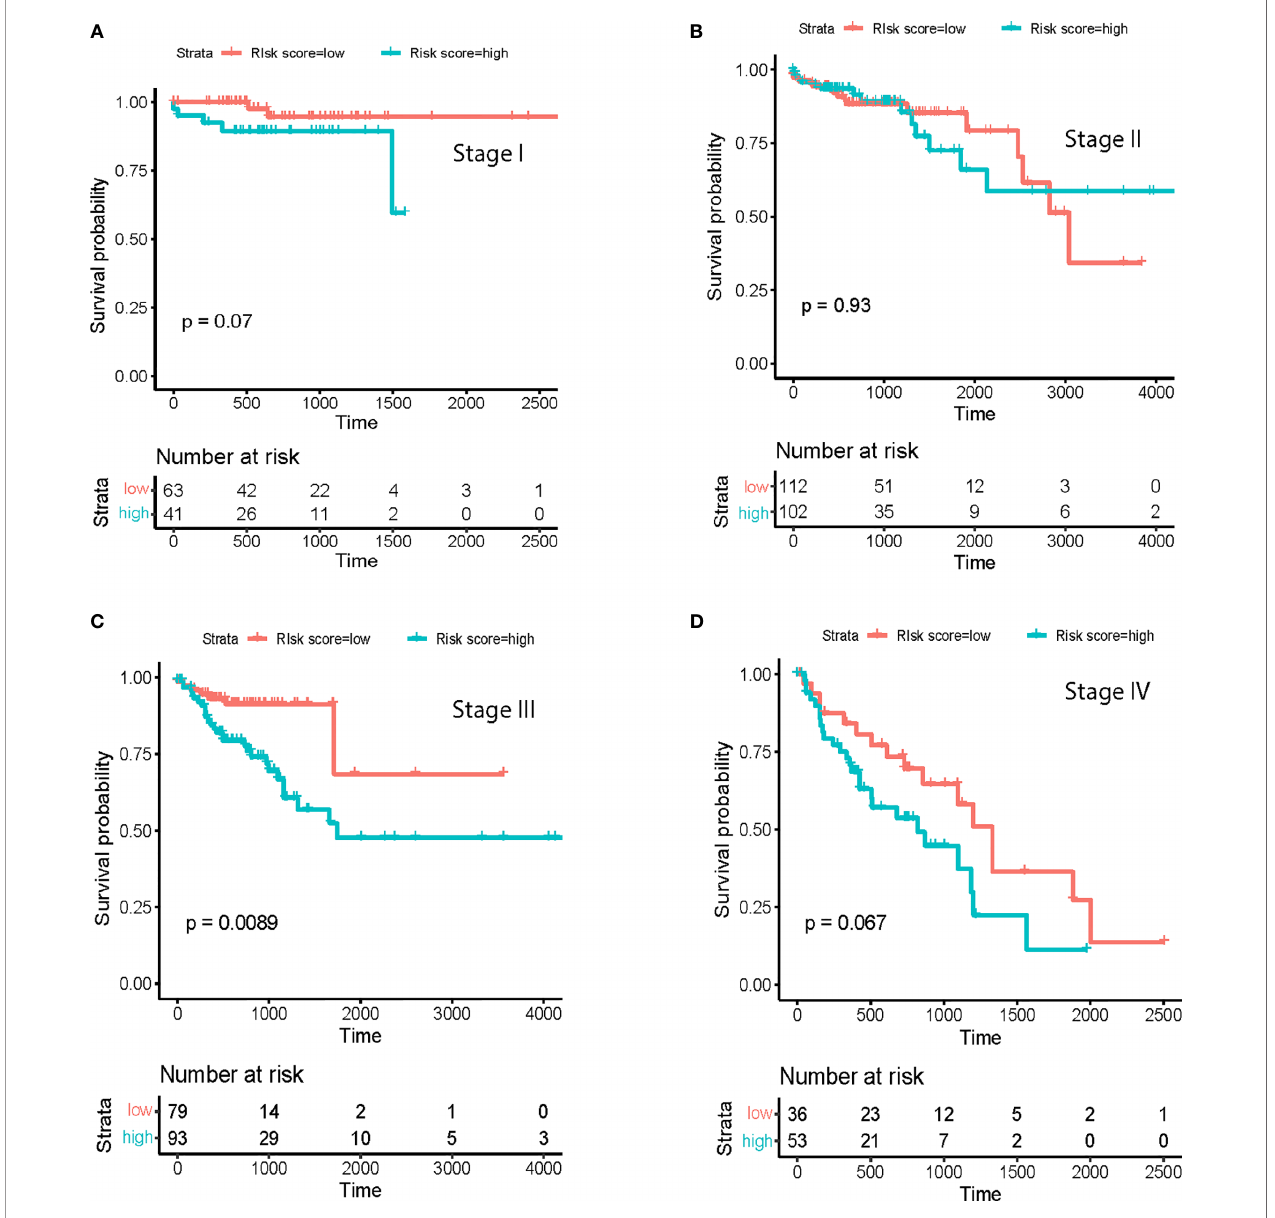
FIGURE 3 | Survival analysis at different cancer stages. Prognostic model in (A) Stage I; (B) , Stage II; (C) , Stage III and (D) Stage